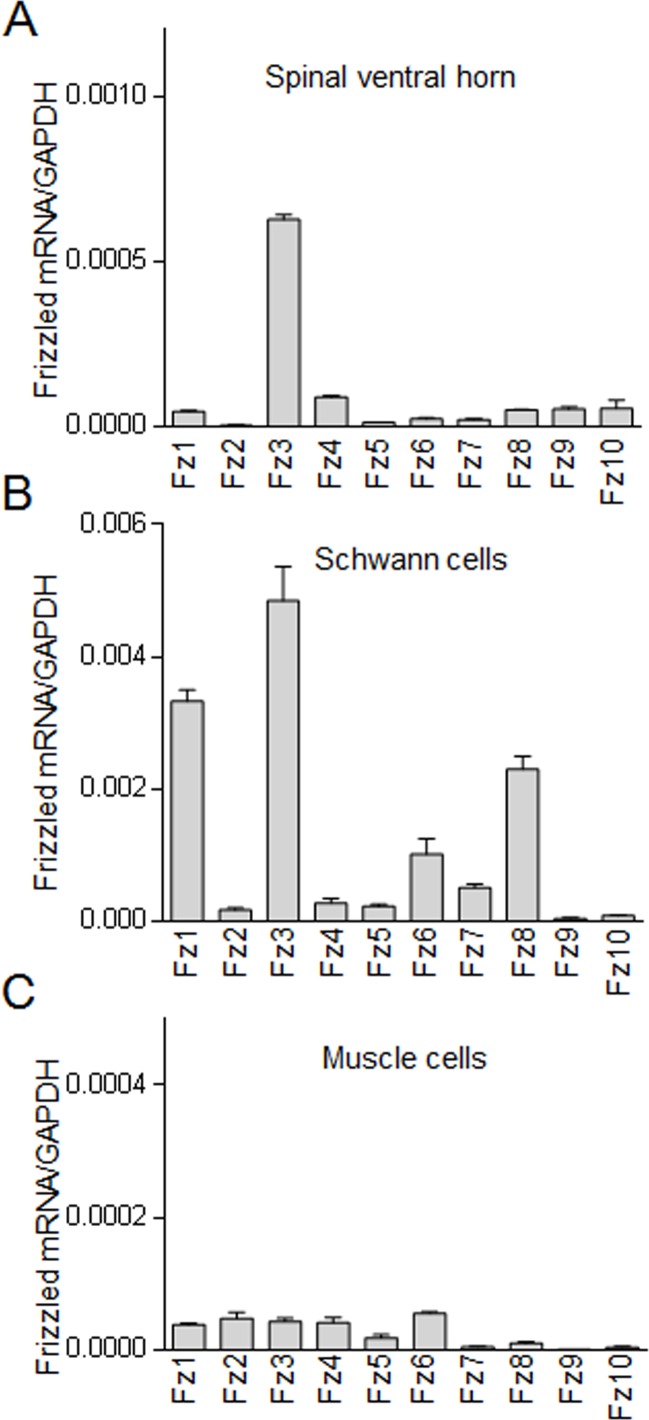
Frizzled expression in spinal ventral horn, Schwann cells, and muscle cells.(A) Expression of Frizzled mRNA in spinal ventral cord. ChAT-EGFP mice were dissected to separate the spinal ventral horn. mRNA was subjected for real-time PCR analysis of Frizzled expression. GAPDH was set as internal control. (B) Expression of Frizzled mRNA in primary Schwann cells. Sciatic nerve in wide type mice (P3) was isolated and disassociated for primary Schwann cells culture, and their mRNA were subjected for real-time PCR analysis. GAPDH was set as internal control. (C) Expression of Frizzled mRNA in muscle cells. C2C12 myoblast was fused into myotubes and their mRNA was subjected for real-time PCR analysis. GAPDH was set as internal control.